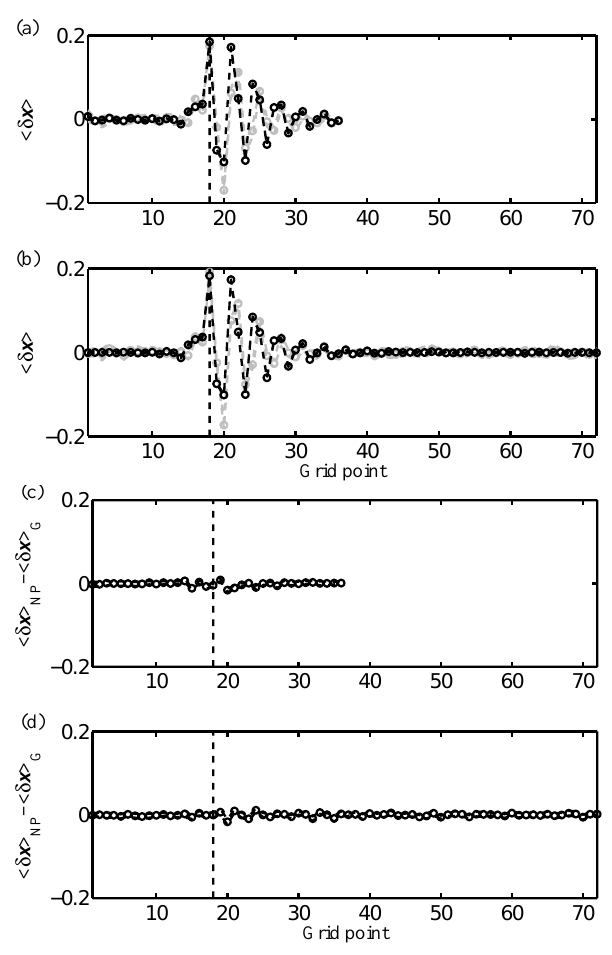
Fig. 5. Response of the deterministic ( a = 0) Lorenz 95 system es- timated using the Gaussian FDT (2), plots (a) and (b) , and the dif- ference between the Gaussian FDT (2) and the non-parametric FDT (A1) as an estimator of (1) without truncation, plots (c) and (d) . The number of elements in the state vector for (a) and (c) is d = 36 and for (b) and (d) is d = 72. The grey lines indicate the true response plotted in Fig. 1 and the RMS difference between the grey and black points is ∼ 75% as indicated by the uppermost straight horizontal lines in Fig. 4. The location of the forcing δf 18 is indicated by the vertical dashed line and statistical error, 2 standard deviations di- vided by the square root of the number of integrations, is smaller than graphical